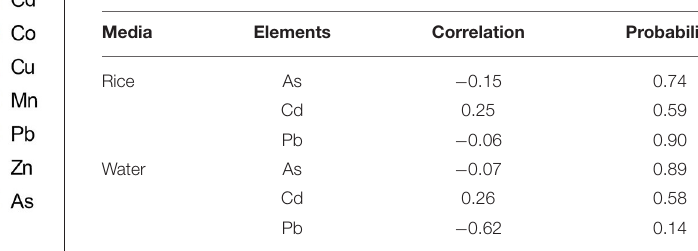
TABLE 3 | Relationship between CKDu prevalence in villages ( n = 9) and heavy metal(loid)s content in raw rice and